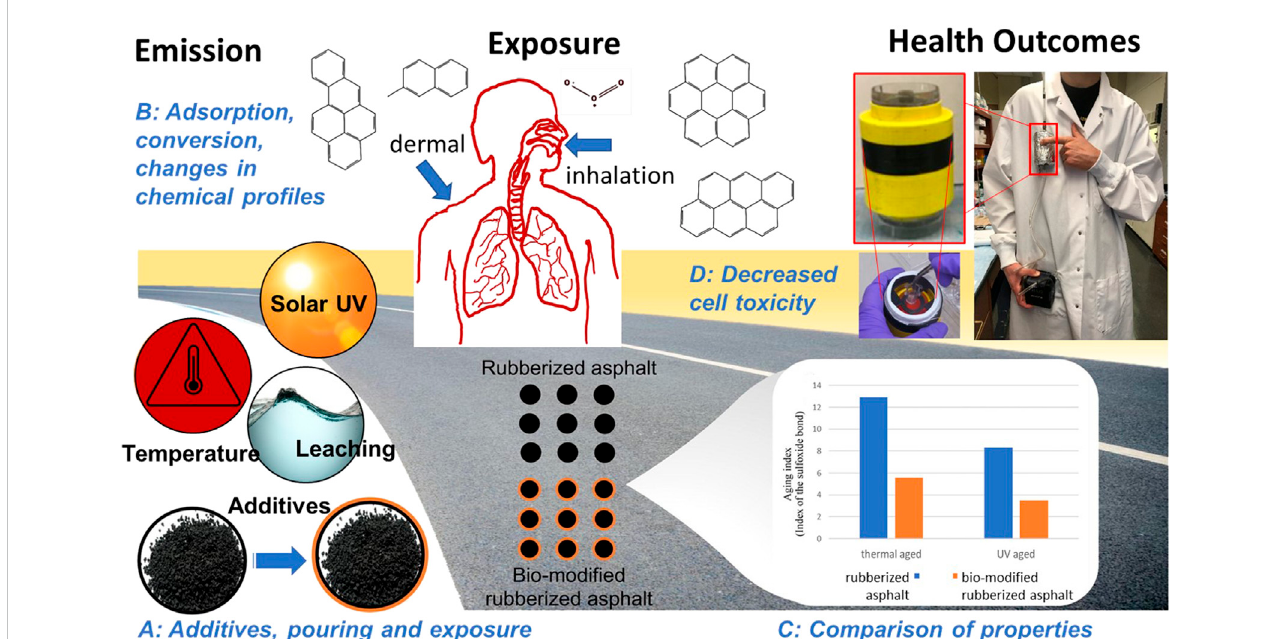
FIGURE 1 Overview of asphalt research: From modi fi cations of asphalt materials and resulting changes in emission (Rajib and Fini, 2020; Mousavi et al., 2021; Lyu et al., 2022) to studying the health effects of these modi fi cations (Secondo et al., 2019;Secondo et al., 2022). Understanding healtheffects ofasphalt requires investigation of emission, exposure and health outcomes, and interventions at the following stages, A – D. Stage (A) Additives, pouring and exposure: Modi fi cations to asphalt compositions as well as subsequent changes aggravated by environmental conditions such as light and heat can affect the emissions of asphalt throughout its life-cycle. For example, bio-modi fi ed rubberized asphalt binder is shown as an example in this fi gure. Traditionally, the physicochemical properties of bio-modi fi ed vs. non-modi fi ed rubberized asphalt was compared. Similar arguments can be made for other modi fi cations to asphalt, e.g., the addition of inherently functionalized carbon from lipid and protein-rich biomass such as biowaste or algae originally studied to reduce ultraviolet-induced damages in bituminous materials (Lyu et al., 2022). Stage (B) : Adsorption, conversion and changes in chemical pro fi les: The effects of the modi fi cations made in (A) on emissions needs to be quanti fi ed. For example, addition of functionalized carbon adsorbs precursors of secondary organic aerosolsandthusdirectlyaffectemissions.Stage (C) :Comparisonofproperties.Traditionally,changesinperformancecriteriaofthematerialitselfarestudied. What isneeded, isto couplethe changes inproperties to health effects. This isStage (D) :Decreasedcell toxicity. A new portable invitro exposure cassettefor aerosol sampling will allow quantifyingthechangesmade toemissionsto health effects, because thecassettefor the fi rst time allows real-time monitoring of cellular oxidative stress (Secondo et al., 2019; Secondo et al.,